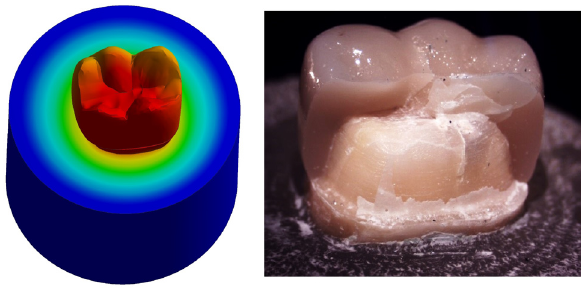
Figure 13. Correlation between total deformation (left) and fracture behavior (right) of Group